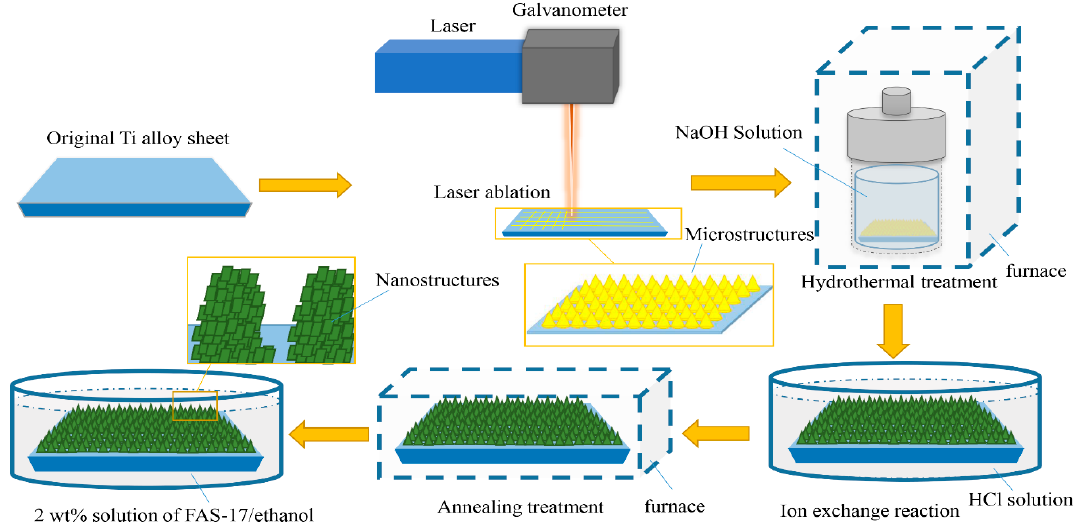
Figure 1. Schematic illustration of the fabrication process for the superhydrophobic Ti alloy.